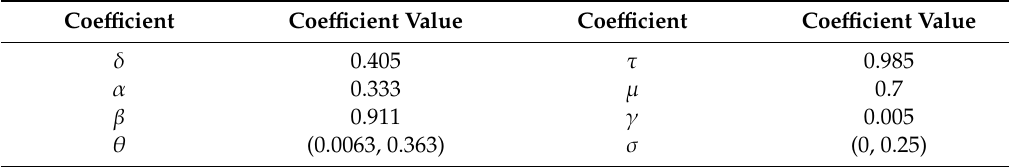
Table 2. The coe ffi cient values of Chaohu Lake in 2018.